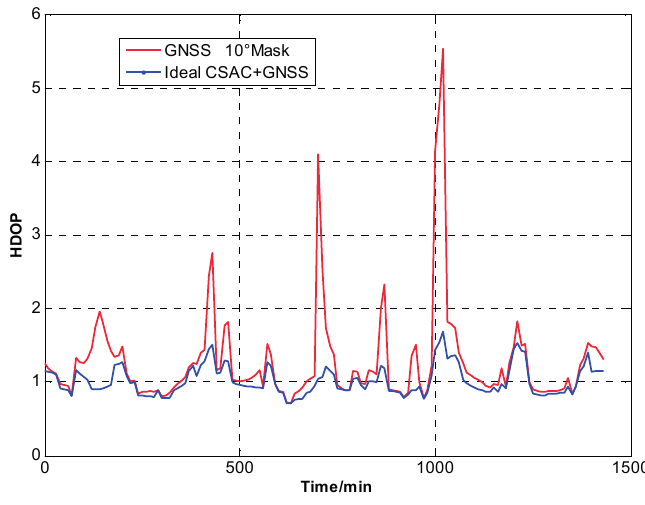
Figure 8. PDOP comparison at 10° cutoff.